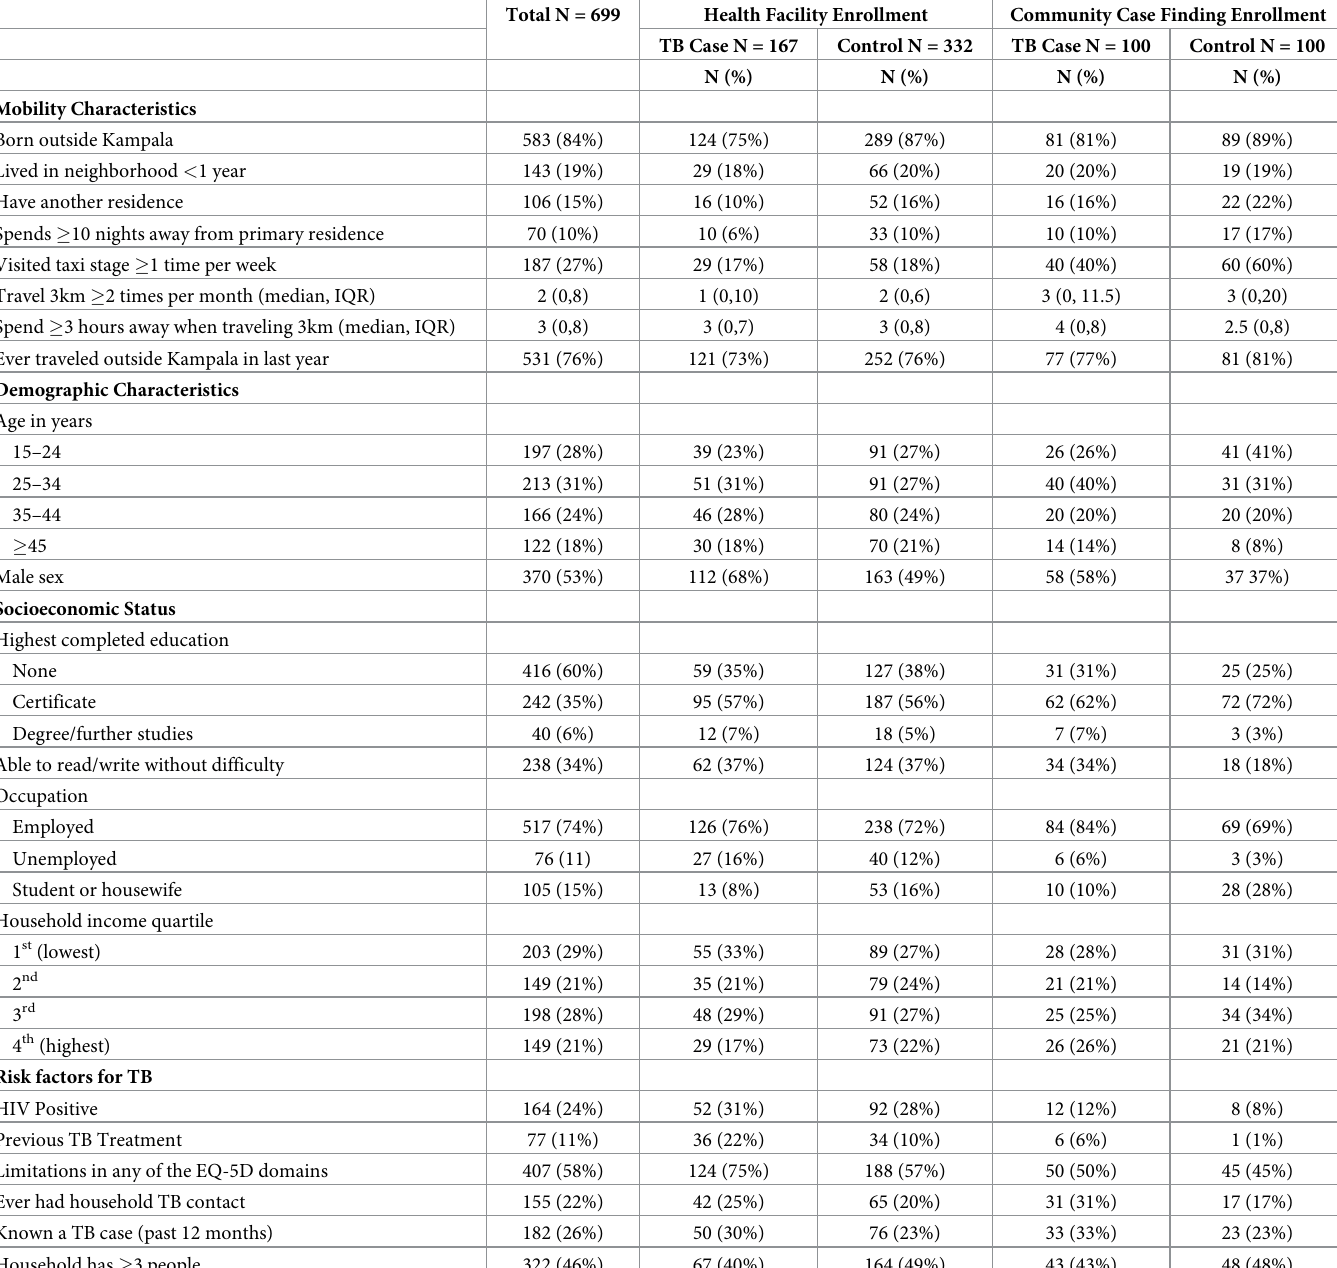
Table 2. Characteristics of people with and without TB in an urban Ugandan